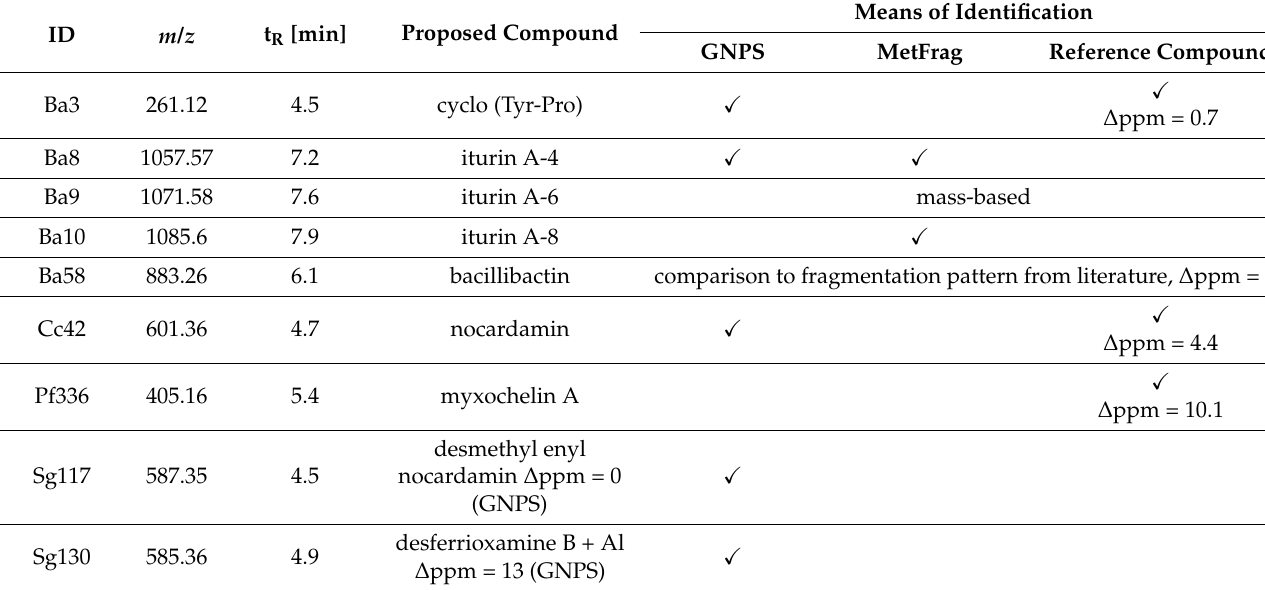
Table 7. Results of fragmentation pattern analysis of selected new mass features. The new mass features were identified by the fragmentation pattern library of the web-based mass spectrometry ecosystem Global Natural Products Social Molecular Networking (GNPS), MetFrag or a reference compound. Evidence is given in the Supplementary Material. A summary of the experimental fragmentation pattern is given in Table S27. The level of confidence for the identification of all compounds is given in Table S28. The ID is composed of the abbreviation of the producer strain (Ba = B. amyloliquefaciens , Cc = C. coralloides , Pf = P. fallax , Sg = S. griseochromogenes ) and the number of the detected new mass